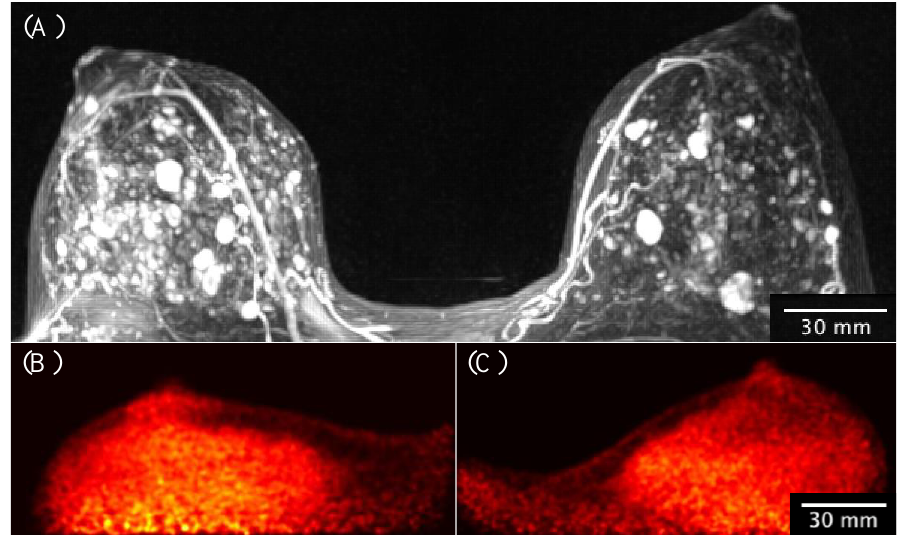
Figure 13. A 33-year-old high-risk female underwent pre-operative breast MRI with multiplicity of enhancing masses demonstrated by the 3D-MIP image ( A ) and without corresponding masses demon- strated by the Radialis PET Camera images ( B ) with a 43 MBq injection. The mediolateral oblique views from the Radialis PET Camera are presented for the left ( B ) and right ( C ) side without evident focal 18 F-FDG uptake in either image. The surgical pathology results do not show signs of